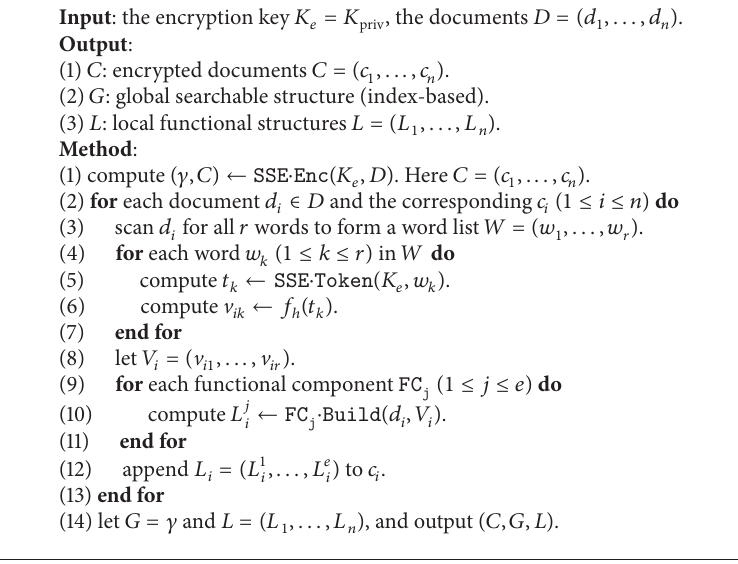
Algorithm 2: Encryption (symmetric): Enc (𝐾 𝑒 ,𝐷) .